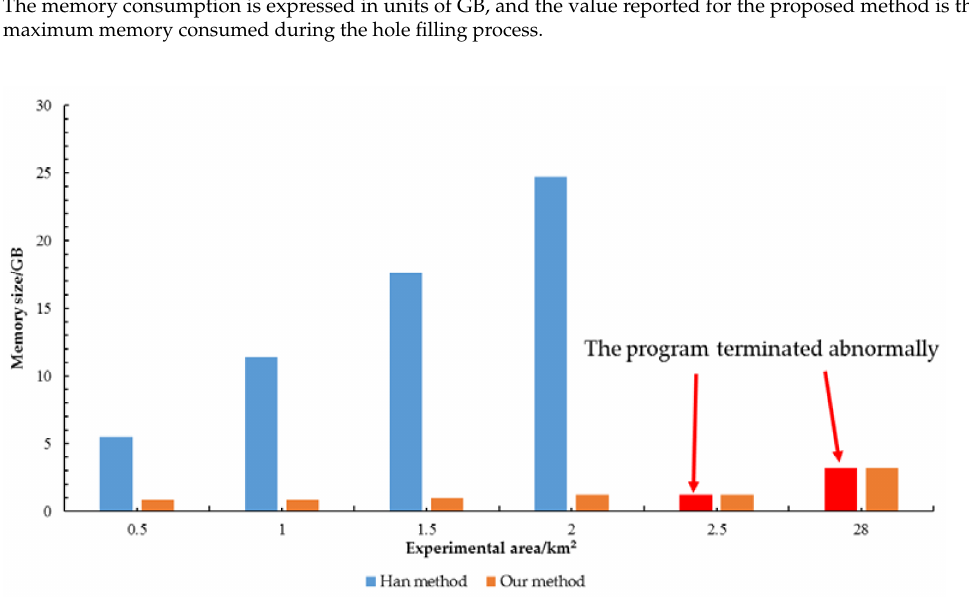
Figure 13. Bar graph for the memory consumption